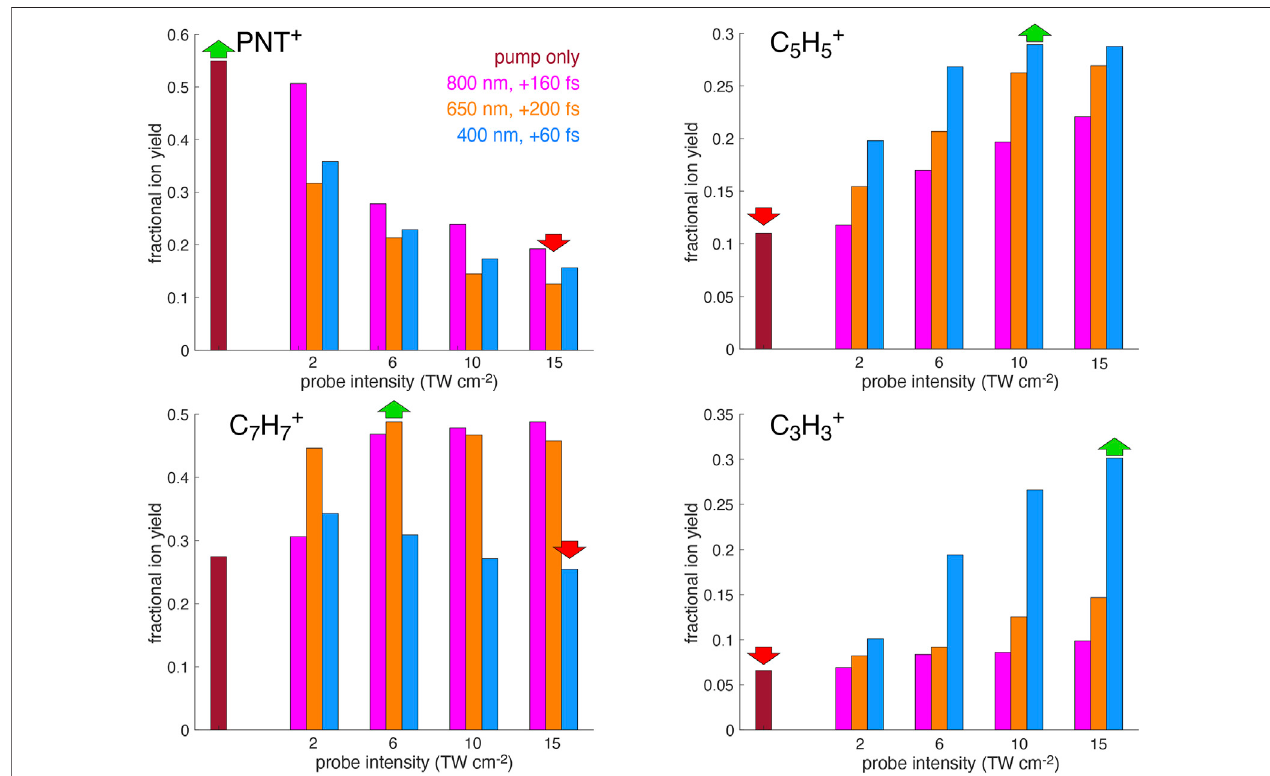
FIGURE 6 | Fractional yields of PNT + , C 7 H 7 + , C 5 H 5 + , and C 3 H 3 + from Eq. 2 obtained using 800 nm, 650 nm, and 400 nm probe wavelengths at intensities from 2 – 15 TW cm − 2 .